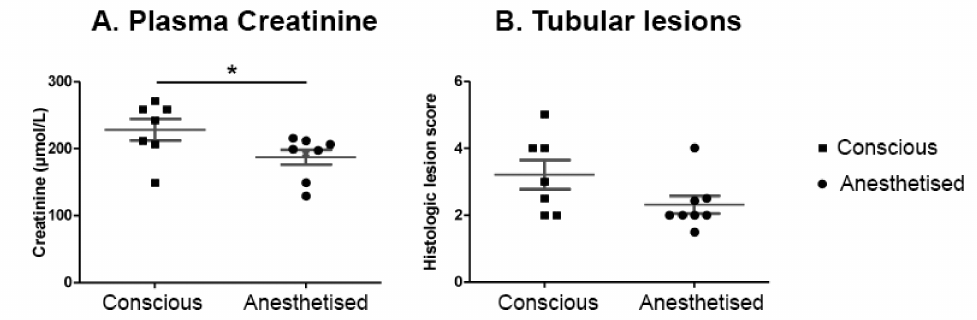
Figure 7. Anaesthesia ameliorated the outcome of a renal ischemia independently of the hypothermia. A 20-min renal ischemia in conscious animals induced a significant increase in plasma creatinine concentration ( A ) and a worsening of the renal lesions ( B ) compared to anaesthetised animals even when the body temperature is maintained at a similar level. Individual values are plotted, and the bars correspond to the average ± s.e.m. * p < 0.05 (Student’s t